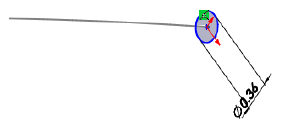
Figure 13. Drawing a circle in a perpendicular plane to the Spline curve.